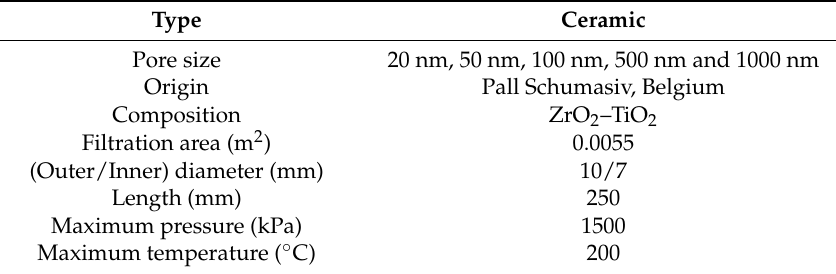
Table 2. Characteristics of experimented ceramic